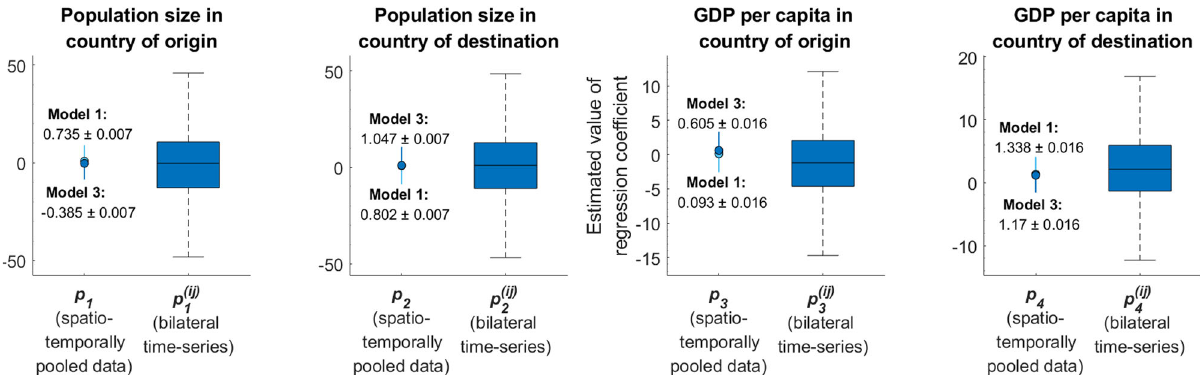
Fig. 5 Regression coef fi cients based on spatio-temporally pooled data and bilateral time-series. Light and dark blue markers represent the regression coef fi cients in Models 1 and 3 (Eqs. (1) and (3)), respectively, estimated based on the spatio-temporally pooled annual observations (cf. Supplementary Table 1). Boxplots represent the distributions of the analogous coef fi cients estimated based on the migration time-series between speci fi c countries of origin and destination (Eq. (10)). Outliers, ranging between [ − 3730, 5746] for p 1 , [ − 9799, 5363] for p 2 , [ − 336, 386] for p 3 , and [ − 260, 1164] for p 4 , are not shown.